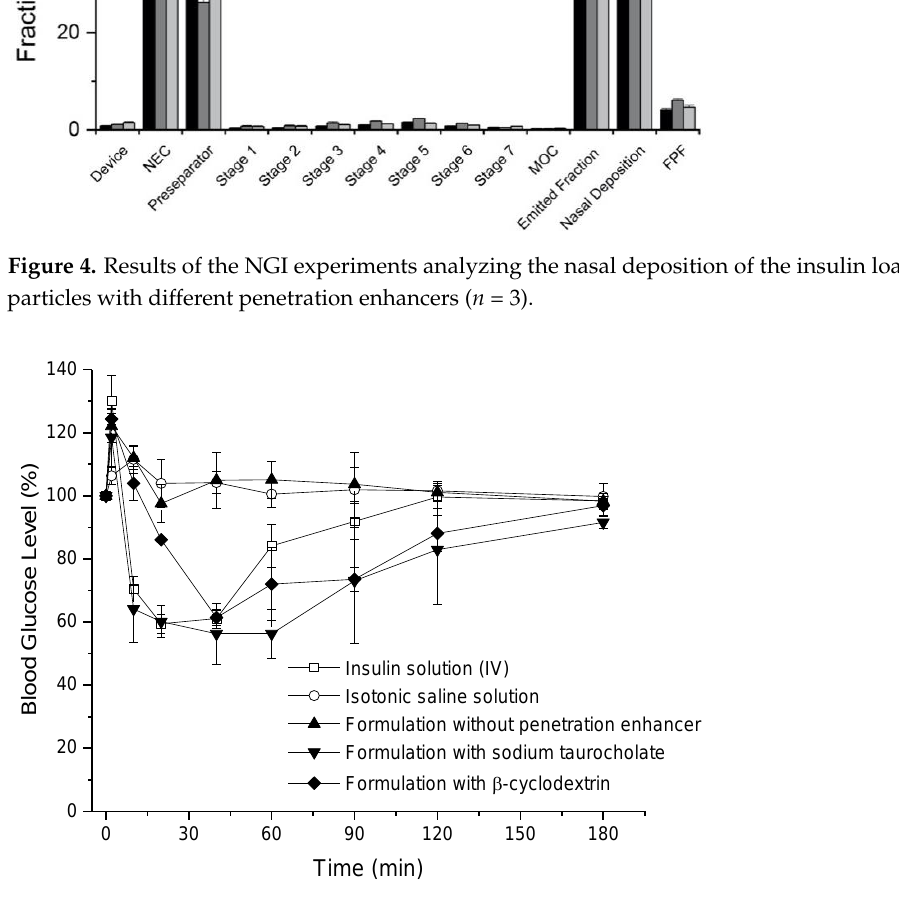
Figure 5. Effect of insulin loaded SFD particles with or without penetration enhancers after nasal administration in rats. Table 4. Pharmacokinetic parameters obtained from the in vivo trials on rats.